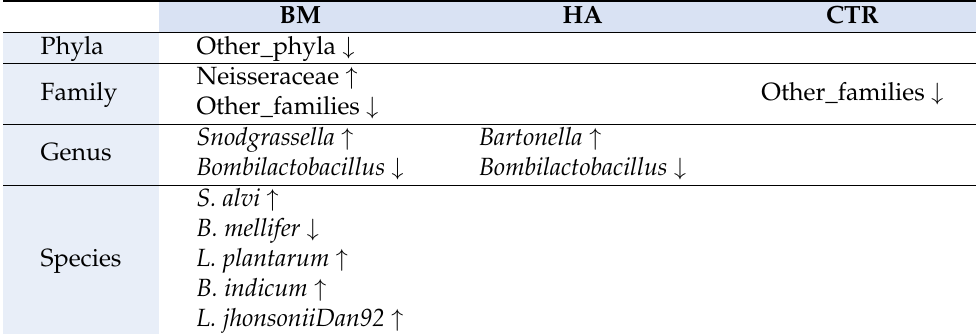
Table 4. Significant variation among microbial groups at phyla, family, genus and species level according to the presented trials and experimental